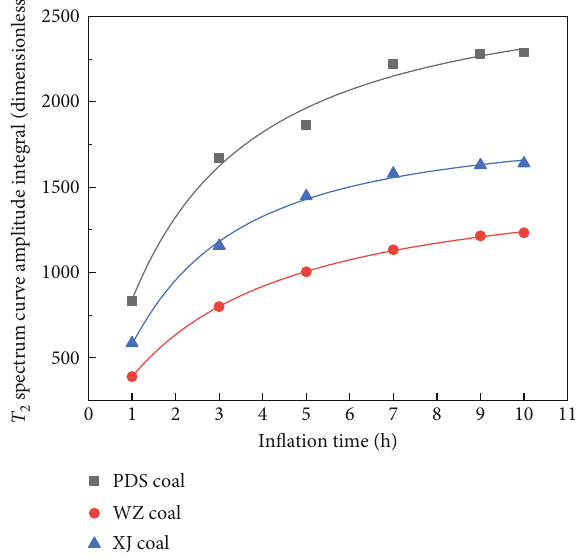
Figure 5: Variation of the integrated gas amplitude in the adsorbed state with the charging